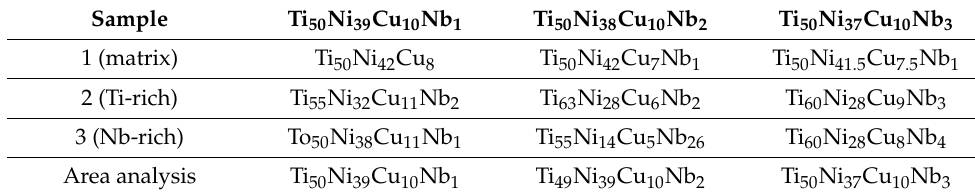
Table 1. EDS analysis results of Ti-Ni-Cu-Nb